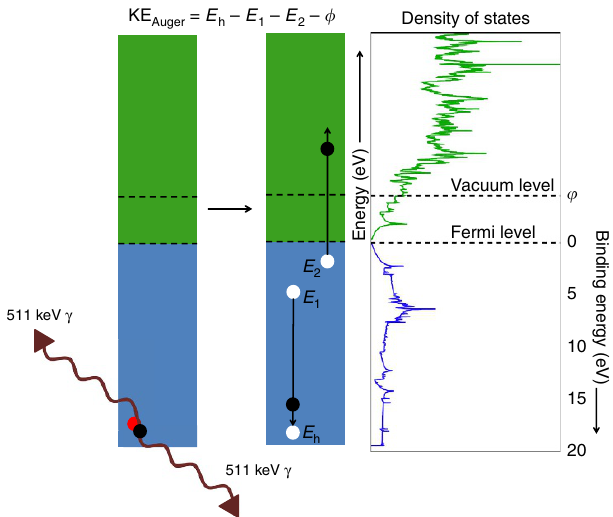
Figure 2 | Schematic representation of the VVV Auger transition. In the first step, a deep hole in the valence band is created by the annihilation of a valence electron with a surface bound positron (first box on the left). In the second step, an electron from a higher level in the valence band falls into the deeper hole and the energy associated with this transition is coupled to another valence electron. Electron emission into the vacuum can occur if the transition results in sufficient energy to overcome the work function. The kinetic energy of the emitted Auger electron is KE Auger ¼ E h (cid:2) E 1 (cid:2) E 2 (cid:2) f where E h , E 1 and E 2 are the binding energies of the electrons involved in the transition (referenced to the Fermi level) and f is the electron work function of the single layer graphene (the middle box). A calculation of the DOS of free standing single layer graphene (far right) shows that the valence band is B 20eVdeep and that a significant fraction of the allowed VVV Auger transitions can result in electrons with the required energy to escape into the